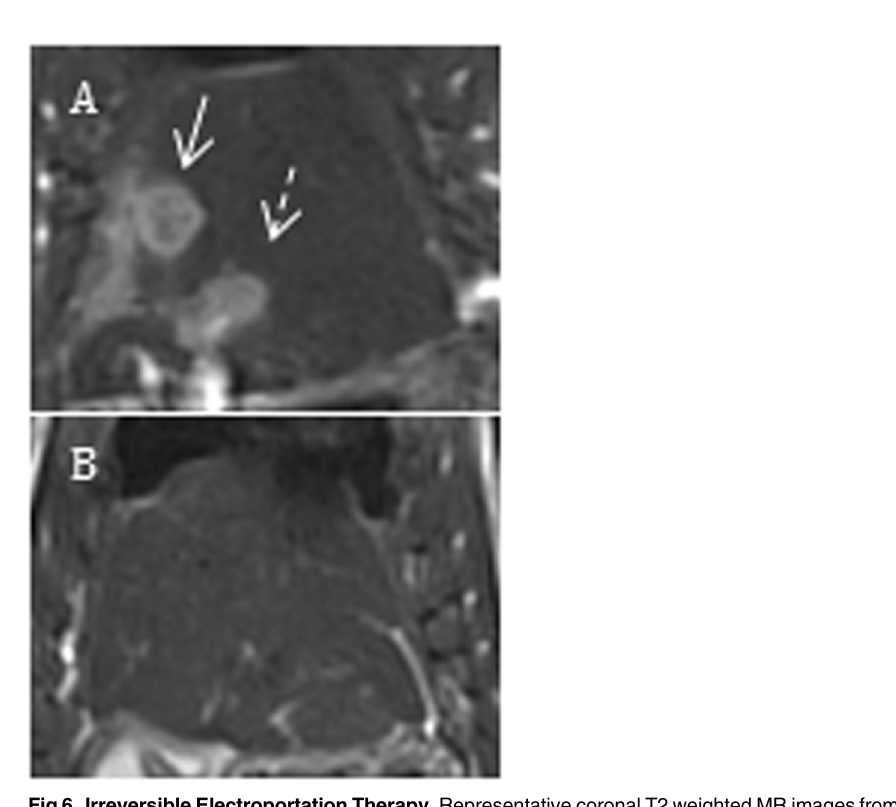
Fig 6. Irreversible Electroportation Therapy. Representative coronal T2 weighted MR images from two Wistar rats prior to IRE (A.I) and 7 days post IRE (A.II). White arrows = control tumors, and dashed arrows = tumors that under went